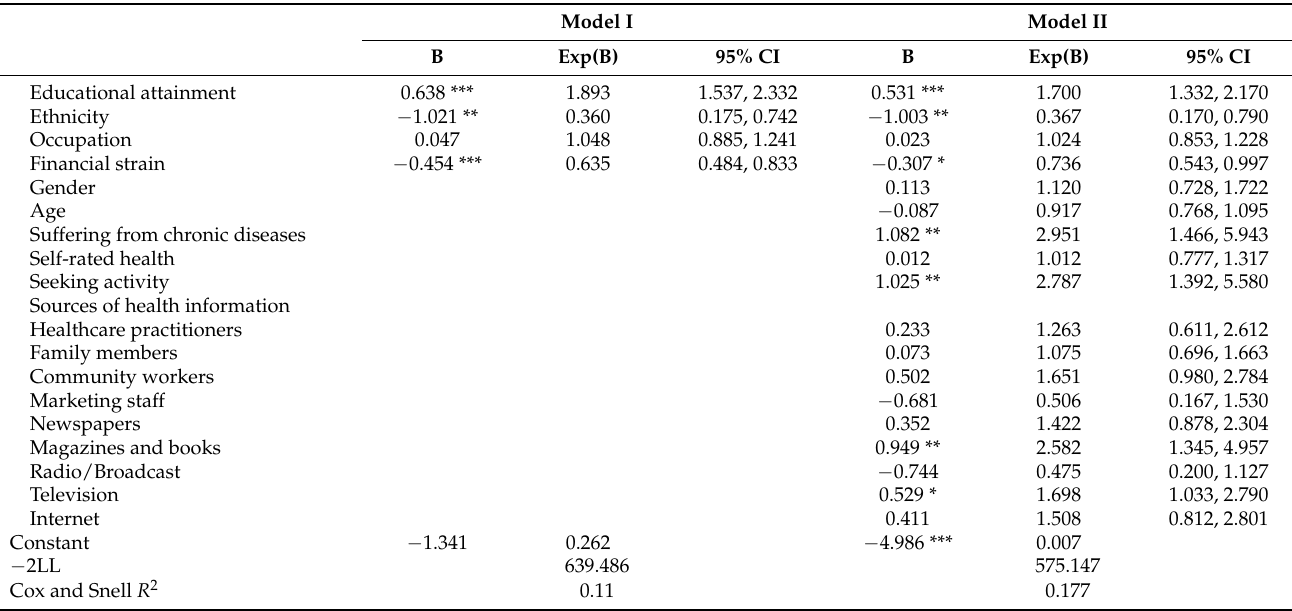
Table 2. Binary logistic regression model of socio-economic status factors associated with health information literacy among urban older